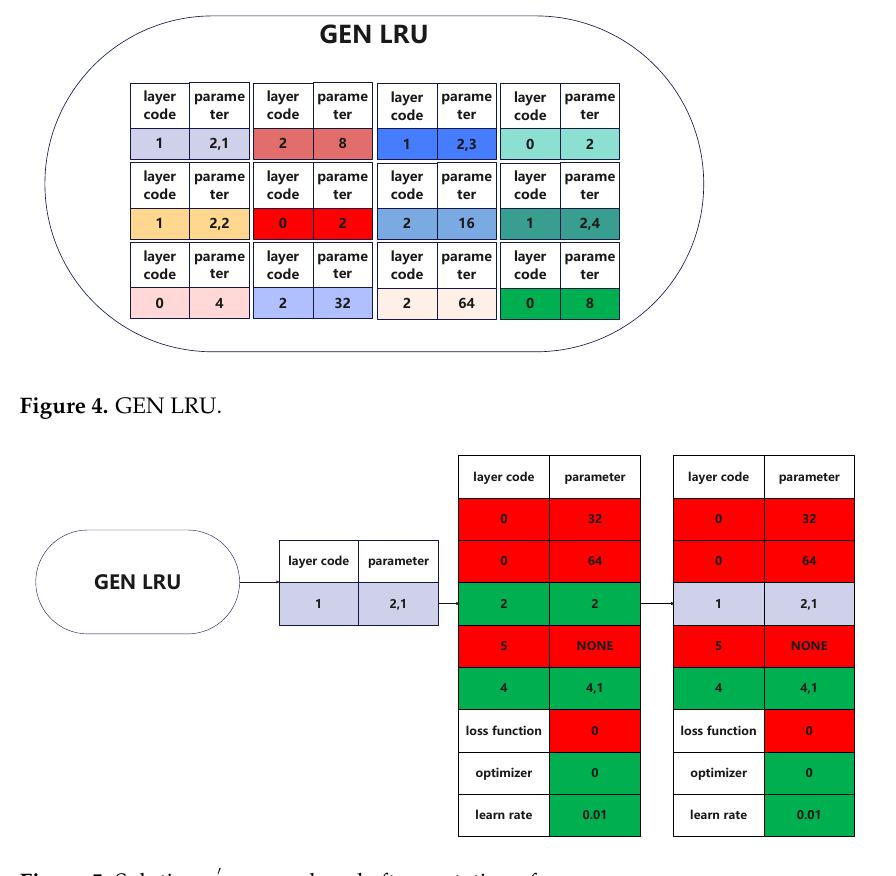
Figure 5. Solution p (cid:48) z are produced after mutation of p z